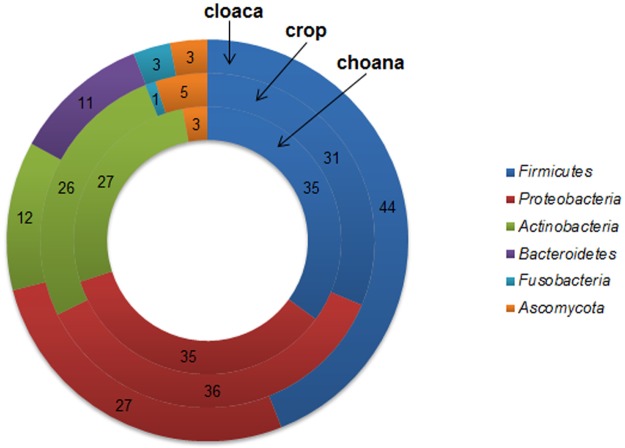
Microbial composition at the phylum/division level.Bacterial phyla and fungal division (Ascomycota) isolated from cloacal (n = 142), crop (n = 111) and choanal samples (n = 69) of the Northern bald ibis (n = 90), displaying the relative abundance of phylum/division-level phylotypes detected (%).